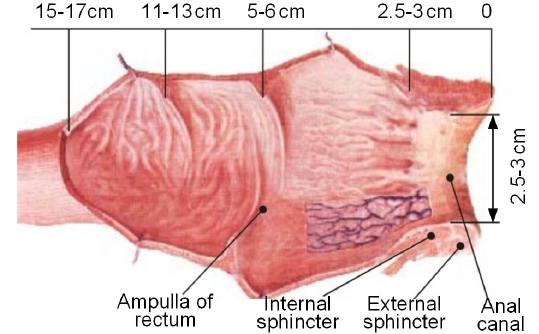
Figure 2. Rectum anatomical diagram.